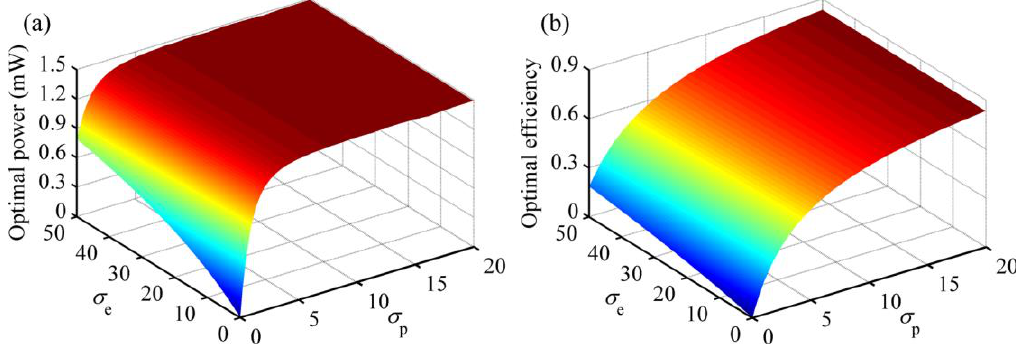
Figure 6. Optimal output power and energy conversion efficiency for different coupling factors σ p and σ e : ( a ) output power; ( b ) energy conversion efficiency.